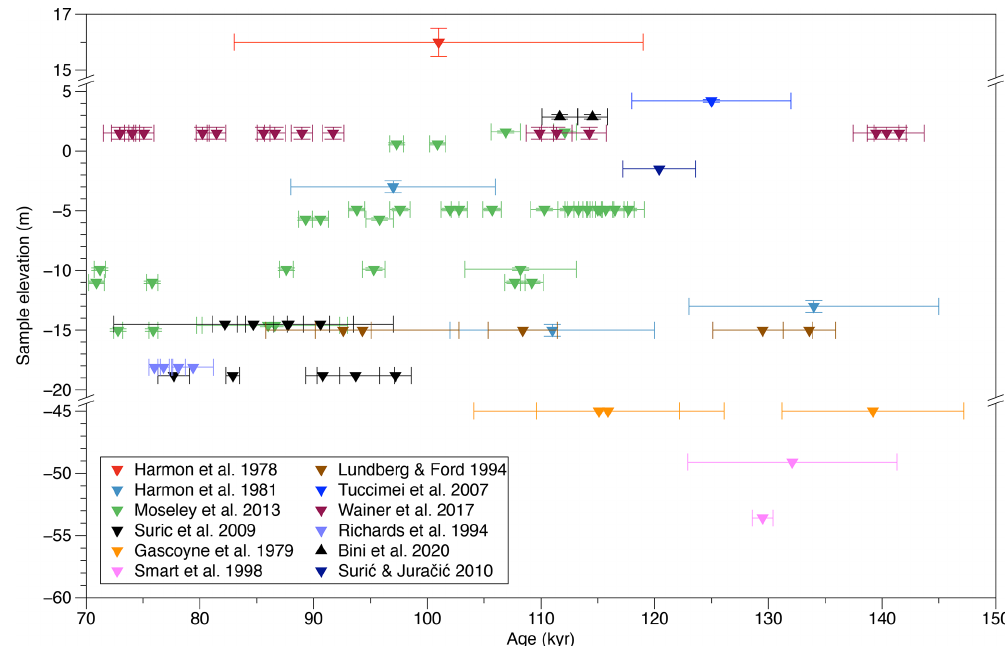
Figure 4. SVS elevations and U-series ages indicating times when RSL must have been lower, hence providing maximum RSL constraints. Note that continuous growth in some of these speleothems could provide more representative results. None of the data are corrected for GIA or long-term